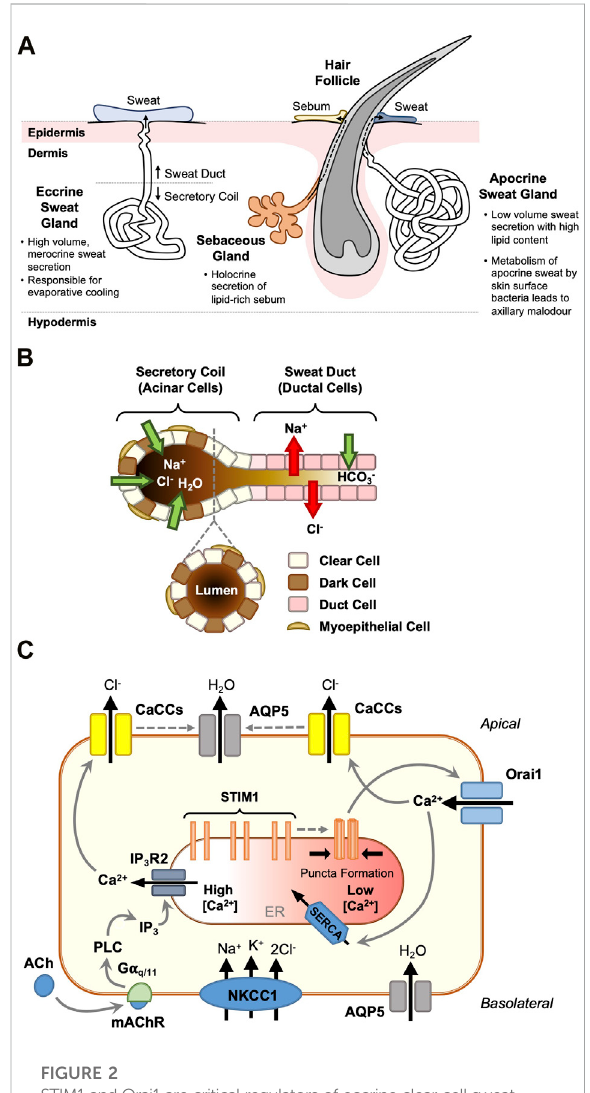
FIGURE 2 STIM1 and Orai1 are critical regulators of eccrine clear cell